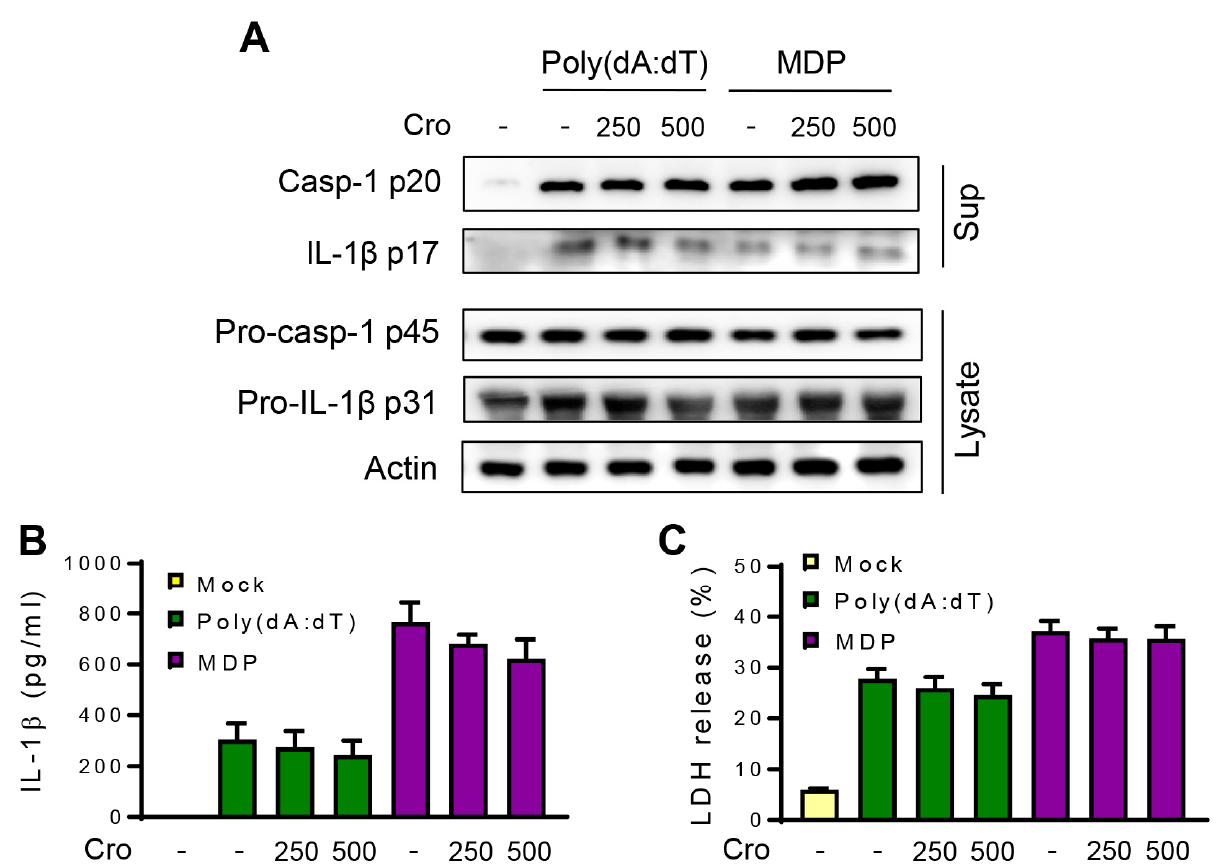
Figure 4. Effects of Crocin on AIM2 and NLRP1 inflammasomes. LPS-primed J774A.1 cells were pretreated with Crocin (Cro, µ M) for 3 h and transfected with MDP or poly(dA:dT). ( A ) After 6 h, cleaved caspase-1 p20 and IL-1 β p17 were detected in the cell culture supernatant by Western blotting. ( B ) IL-1 β in cell culture supernatant was measured by ELISA. ( C ) LDH release was assayed as described in Figure 2. The data are expressed as the mean ± SEM and represent three experiments.